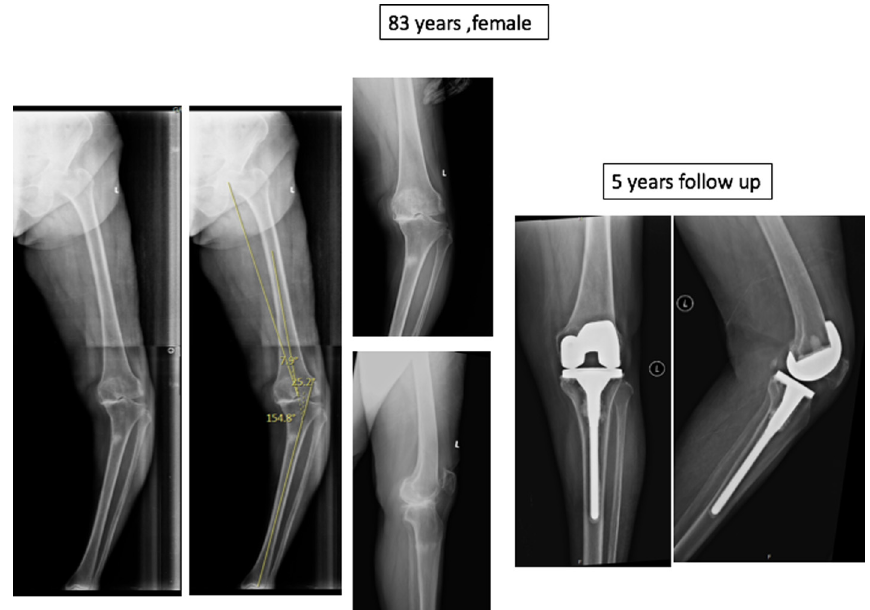
Figure 1. Chronic proximal tibial stress fracture treated with long stem